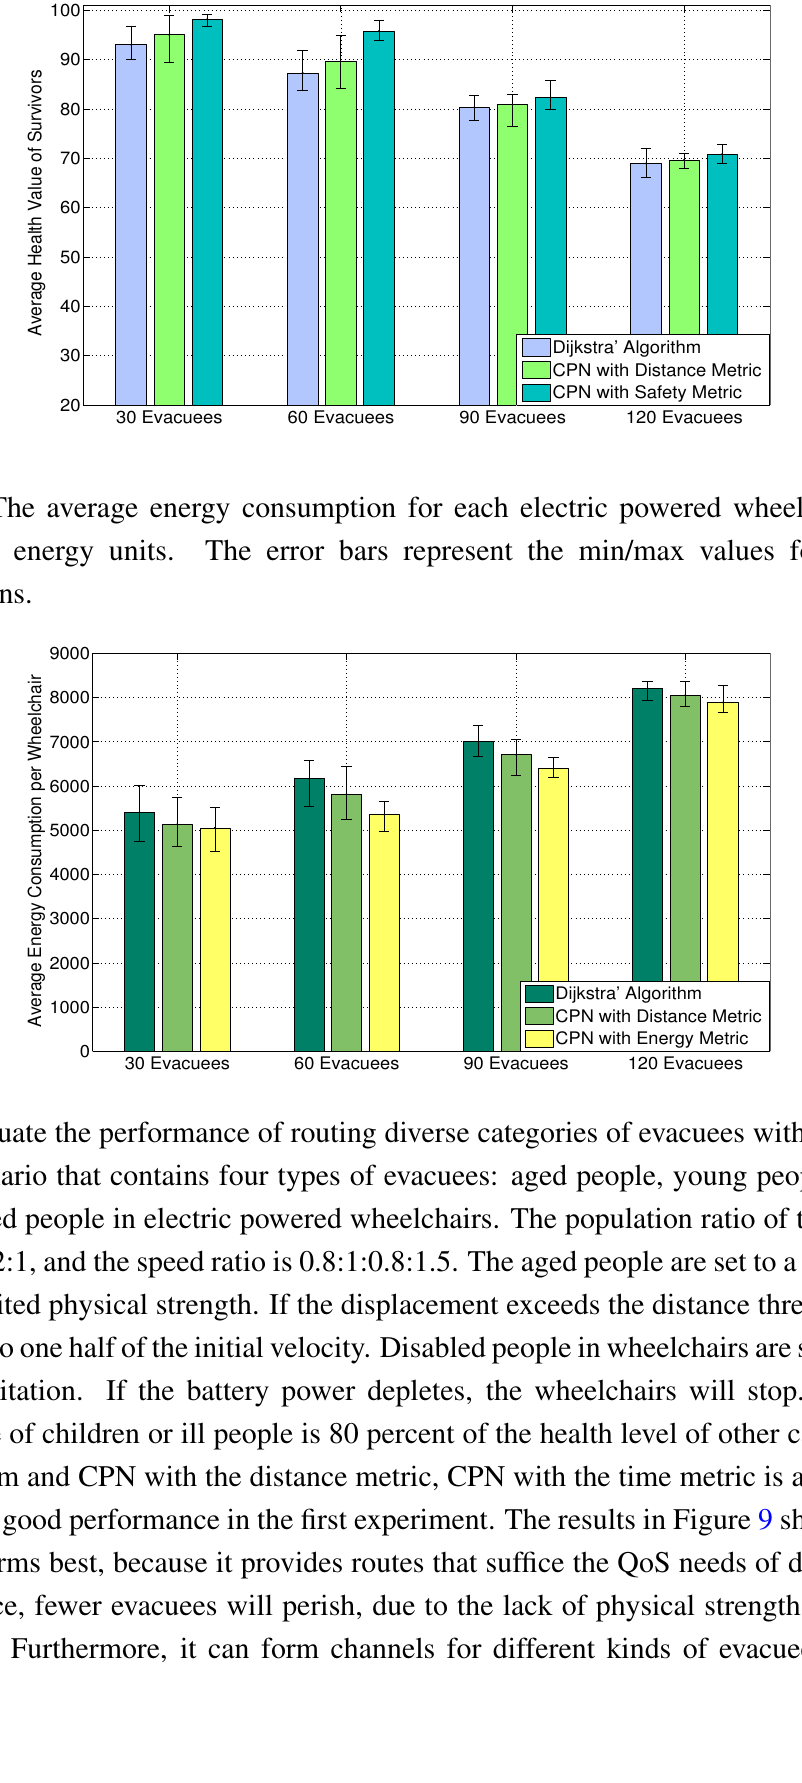
Figure 7. The average health value of survivors in ten iterations. The error bars represent the min/max values found in the 10 simulations.